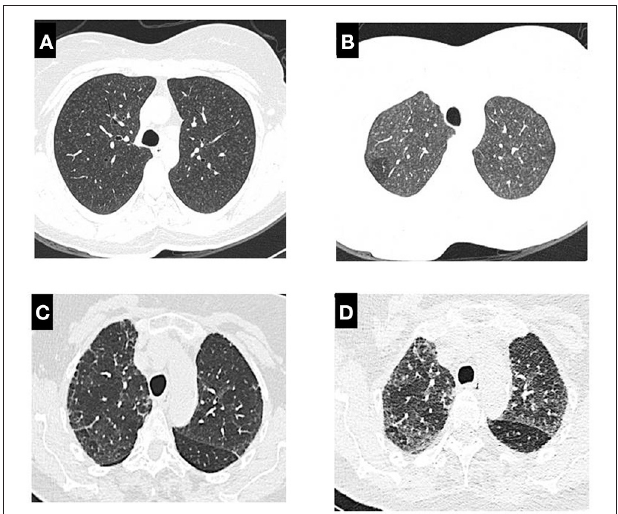
FIGURE 3 | Differential cell count in bronchoalveolar lavage fluid from a patient with hypersensitivity pneumonitis showing strong lymphocytosis. Hematoxylin and eosin staining, magnification: 40 × .